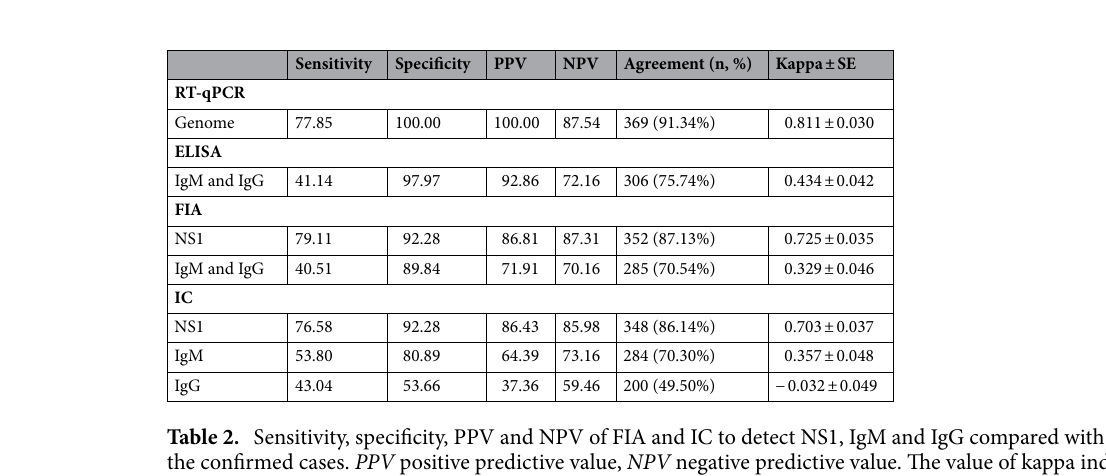
Table 1. Demographic data of the patients.